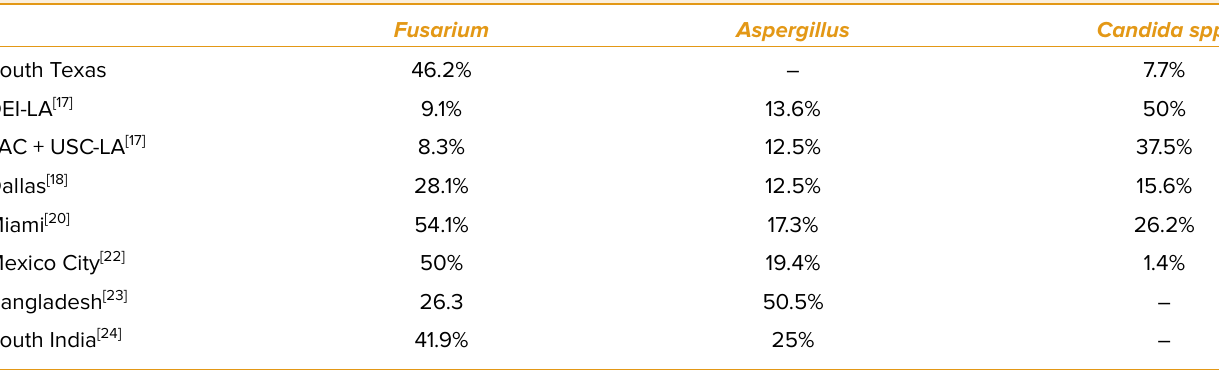
Table 7. Percentage of fungal species retrieved from the total fungal-positive cultures in South Texas compared with other